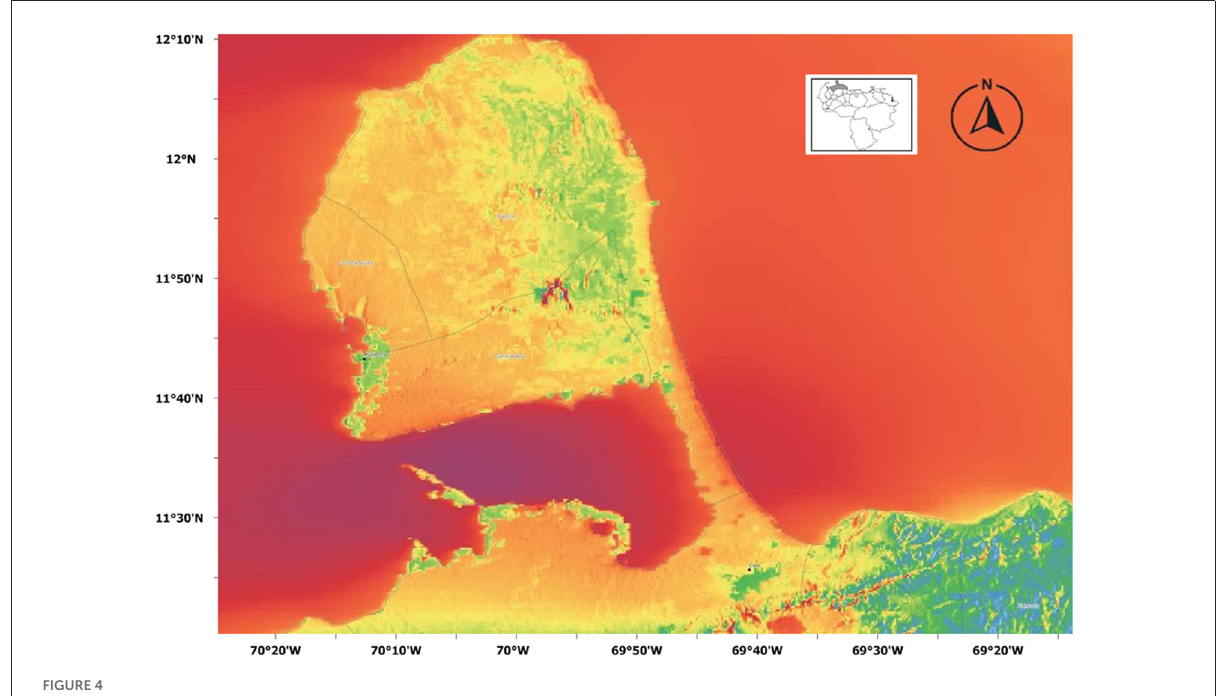
FIGURE4 The central coast of Falcón state,